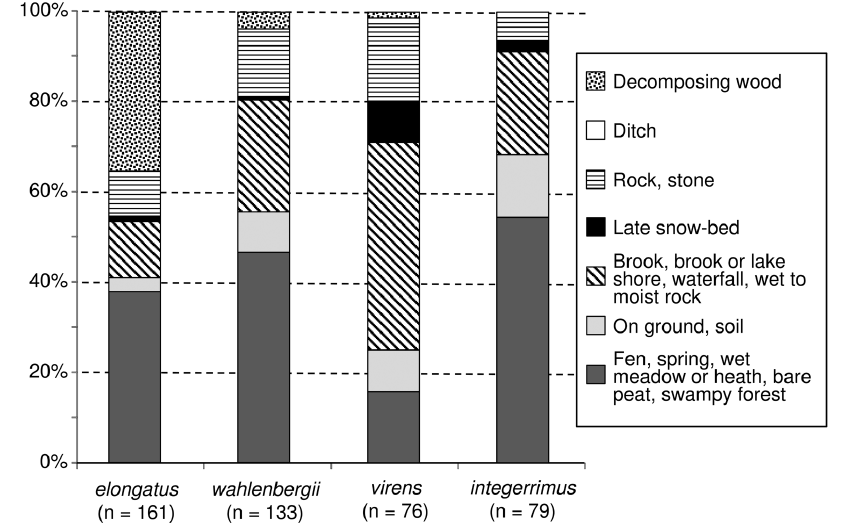
Fig. 4. Habitat preferences of Oncophorus elongatus , O. wahlenbergii , O. virens , and O. integerrimus Hedenäs sp. nov. in Scandinavia, based on label information from studied material in S.